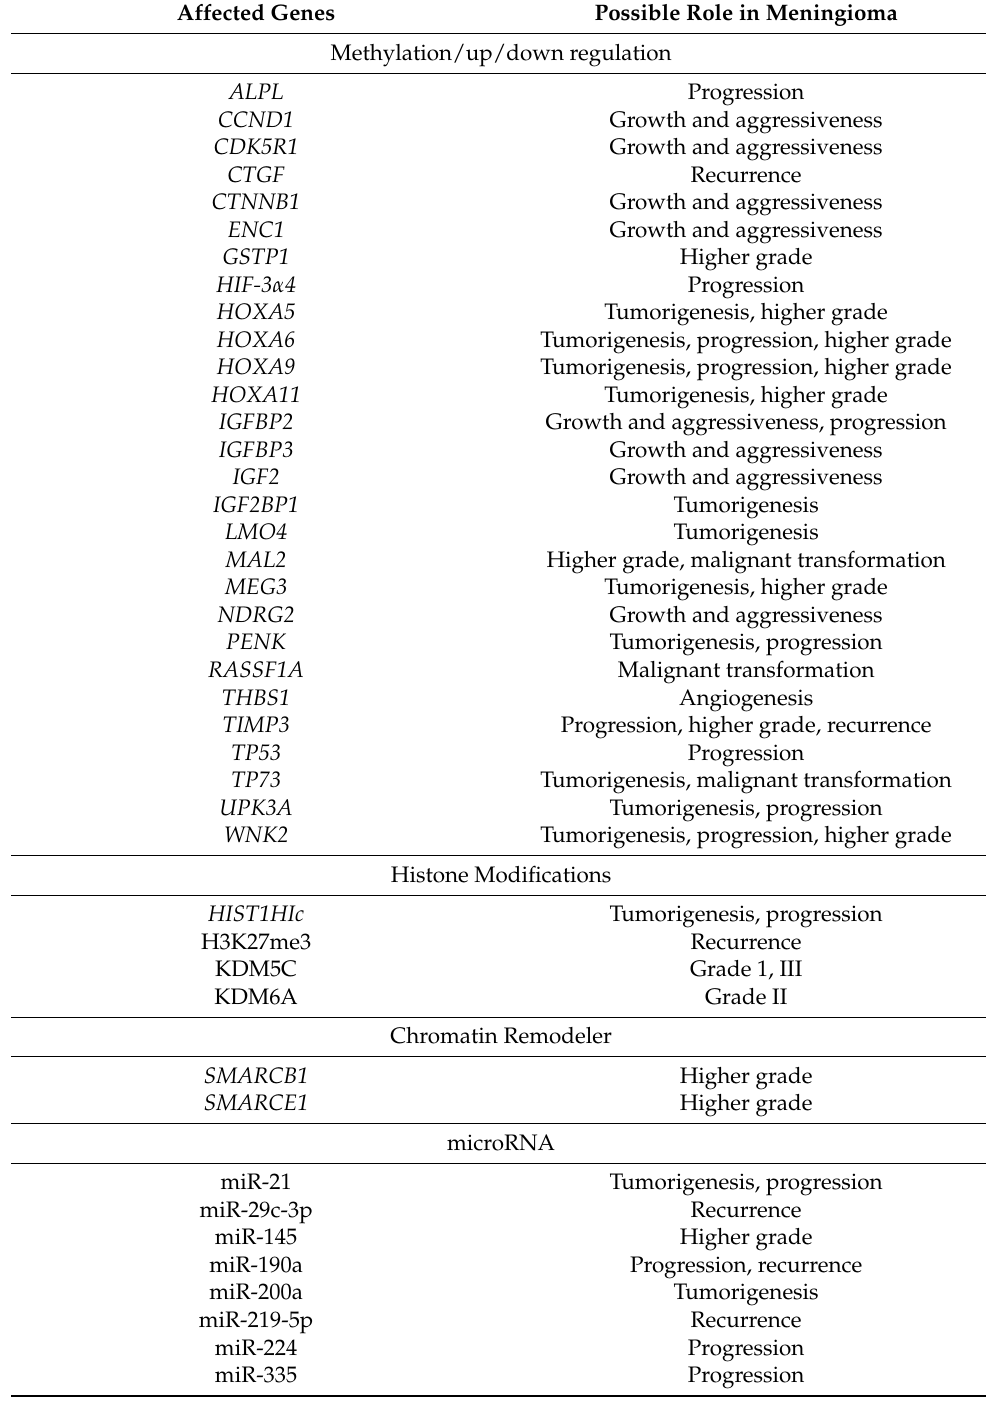
Table 3. Epigenetic modifications in